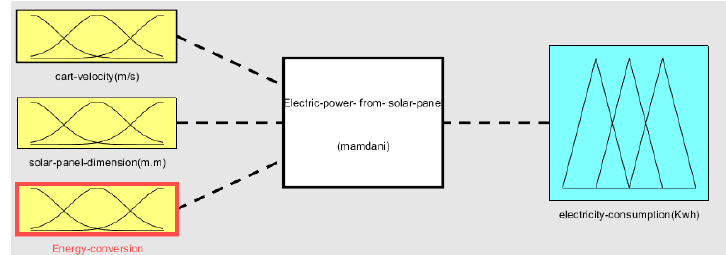
Figure 3. Fuzzy logic system for electric power from solar panel.